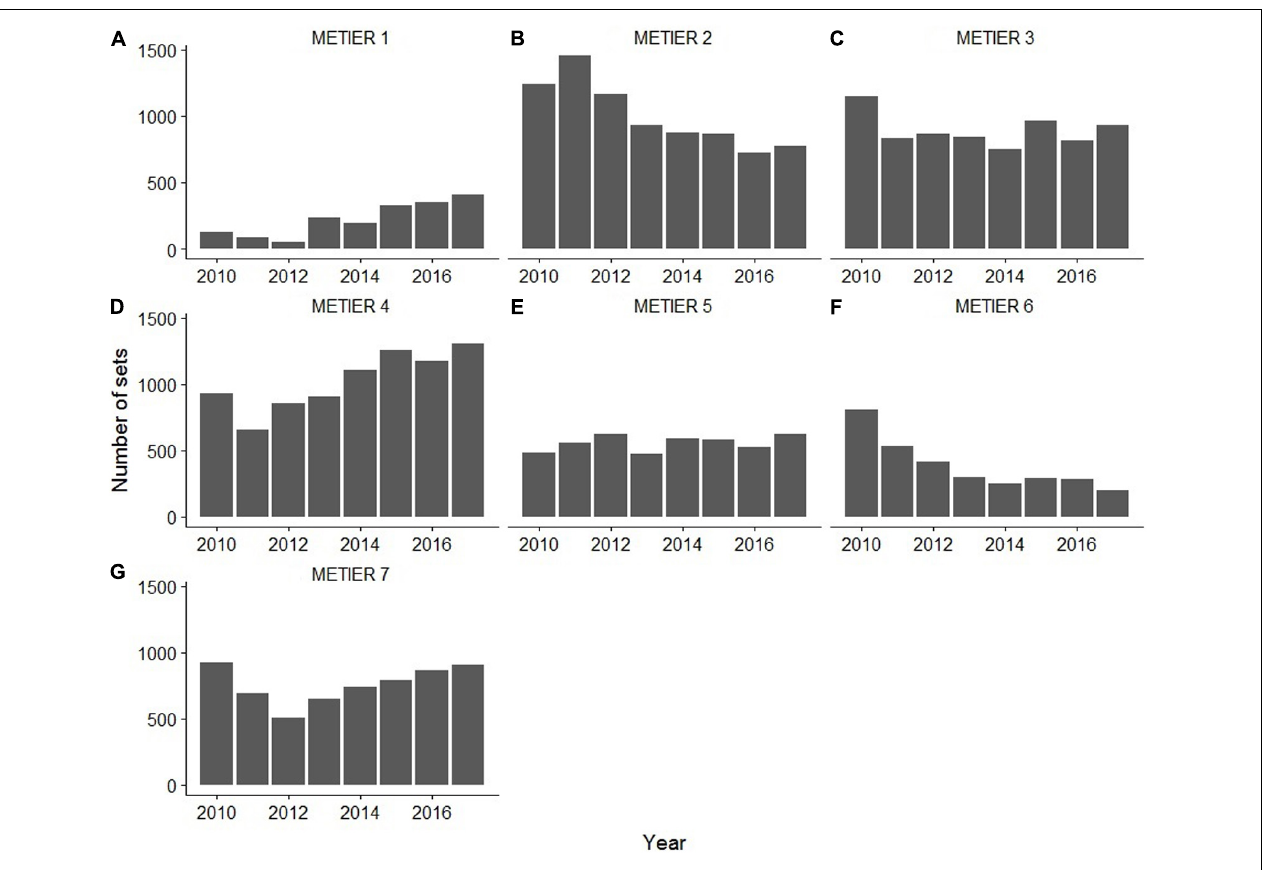
FIGURE 4 | The distribution of sets attributed to each métier annually in the Eastern Tuna and Billfish Fishery (ETBF) between 2010 and